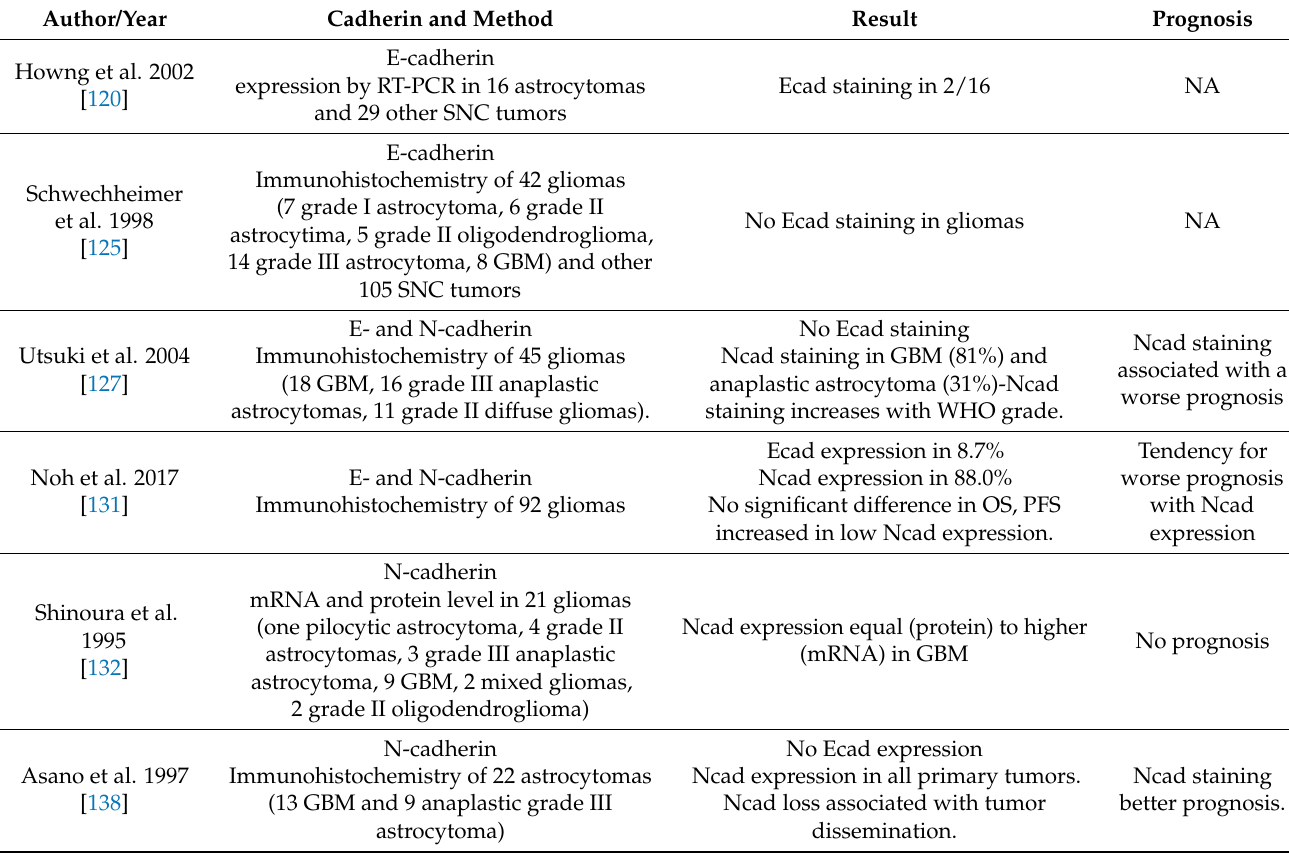
Table 1. Summary of cadherin’s expression and prognosis in different published patient glioma series. NA (not